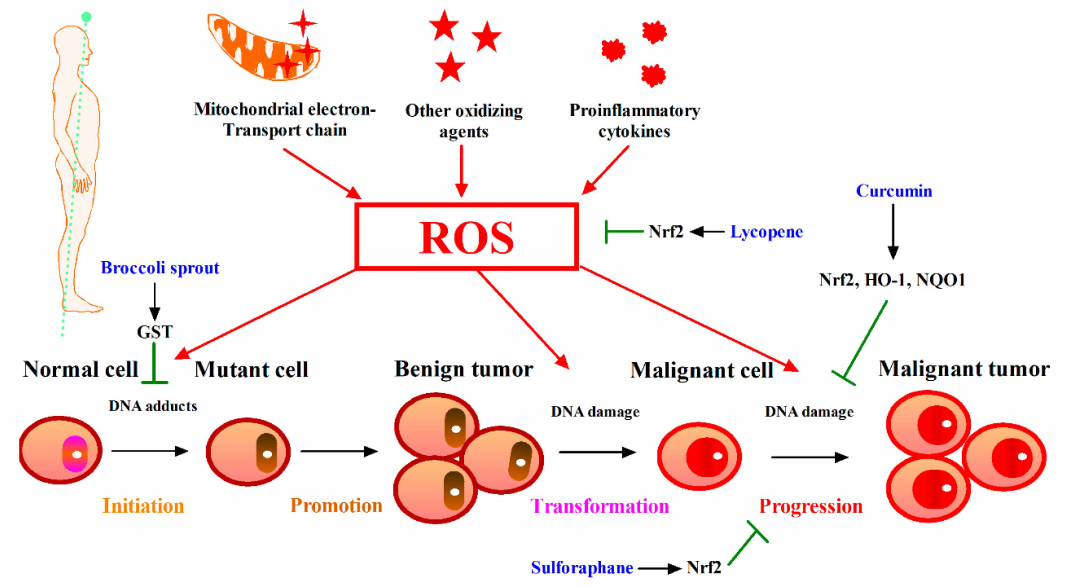
Figure 4. Phytochemicals target Nrf2 for cancer intervention. ROS can promote the transformation of normal cells into cancer cells. Many phytochemicals are reported to prevent cell transforma- tion by ameliorating oxidative stress environment and preventing DNA damage in the early stage of